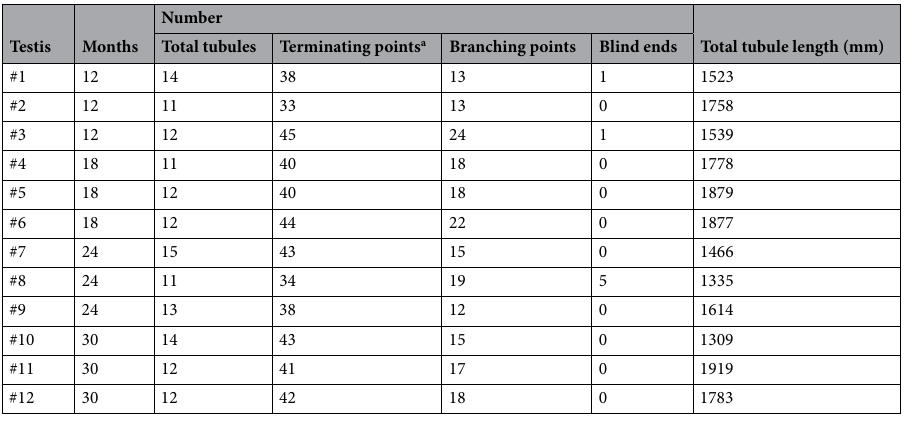
Table 1. Summary of reconstructed seminiferous tubules in aging mouse testes. a Connections with the rete